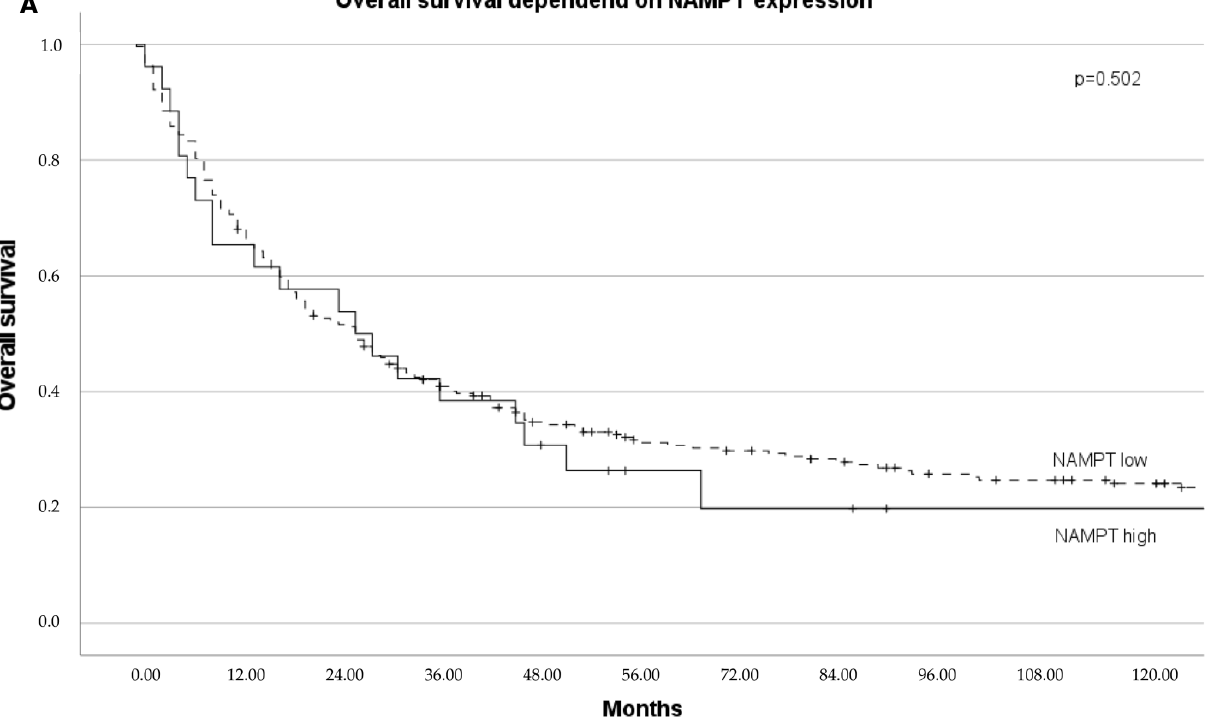
Figure 1. Kaplan – Meier plots of overall survival: ( A ) Overall survival depending on NAMPT ex- pression (NAMPT high — solid line, NAMPT low — dotted line). ( B ) Overall survival depending on